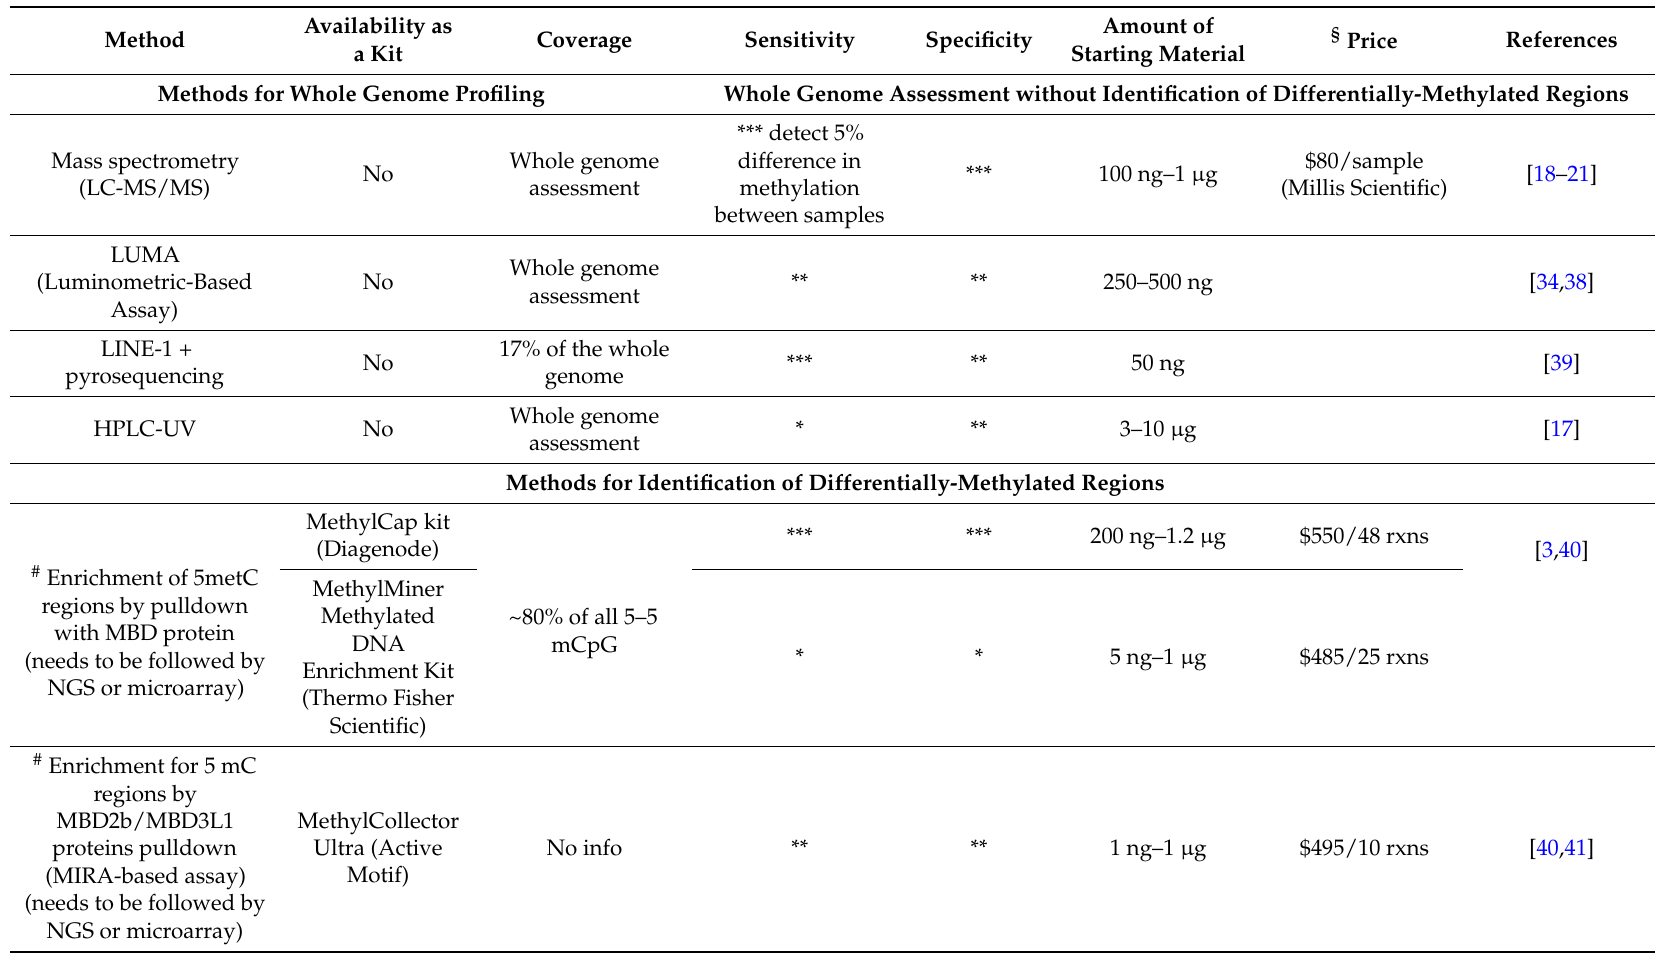
Table 2. Comparison of methods for DNA methylation